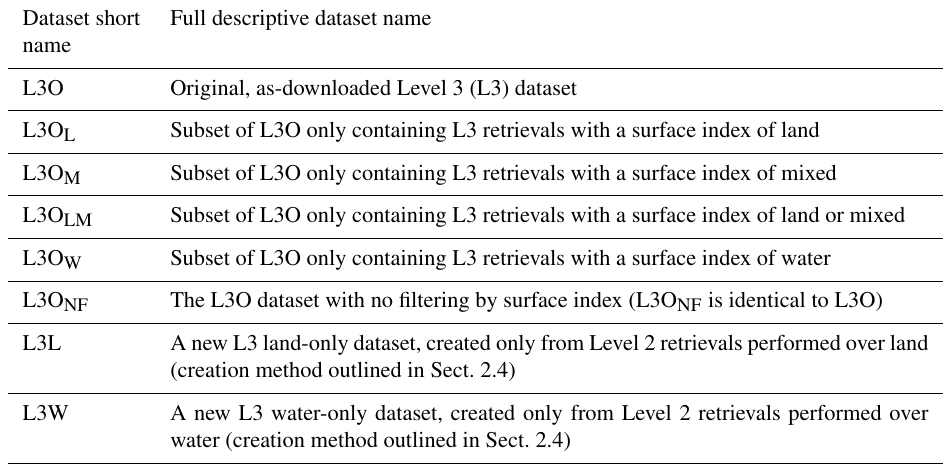
Table 1. List of dataset short names used in the main article text and their corresponding full descriptive name. Dataset